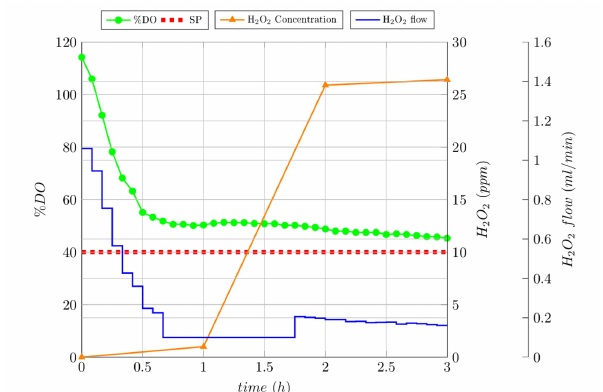
Figure 5. Degradation of Gallic acid under Closed-Loop experiment conditions.